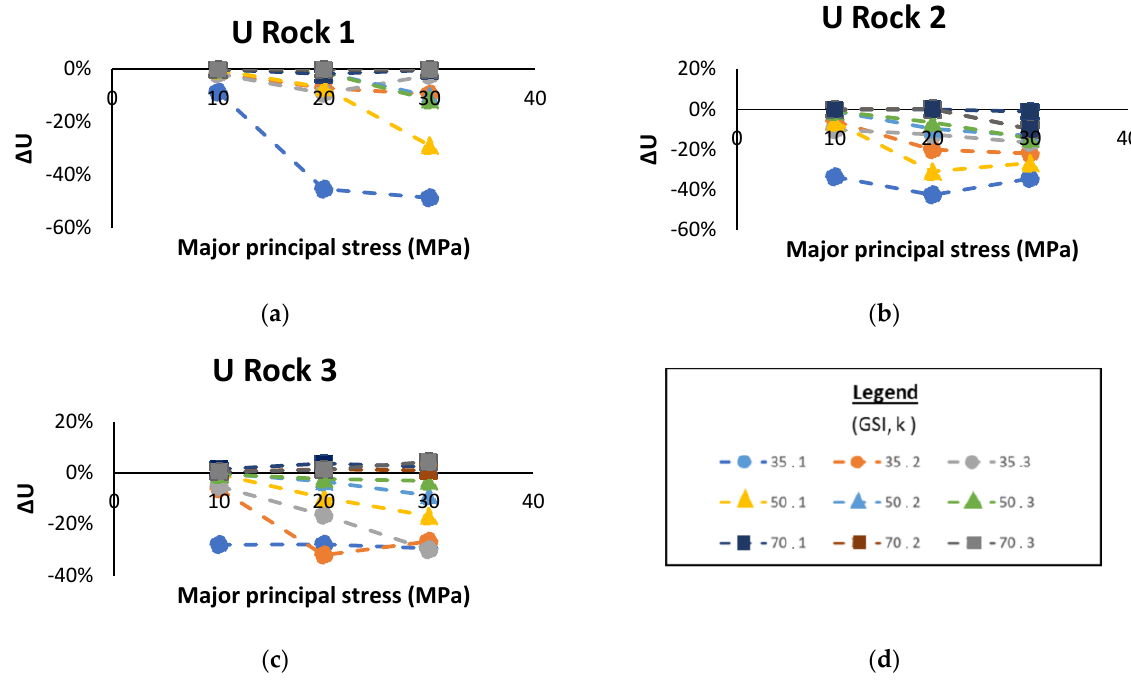
Figure 8. Variation of the relative deviation of wall displacement for an increase in the major principal stress at 10, 20, and 30 MPa, ( a ) Rock 1, ( b ) Rock 2, ( c ) Rock 3, ( d ) legend. For better realization of the stress paths around the tunnel, the isolines of the vertical and horizontal stresses have been illustrated in Figure 9. Figure 9. The isolines of stresses in the ( a ) x and ( b ) y directions. Finally, rock type has a distinct effect on the relative deviation for the displacement. When we select displacement as the control parameter, stronger rocks, characterized by a higher m i and 𝜎 𝑐𝑖 , produce less variation with an increased GSI. Thus, in terms of the displacement of the strong rock, the difference between GHB and EMC is limited. For a